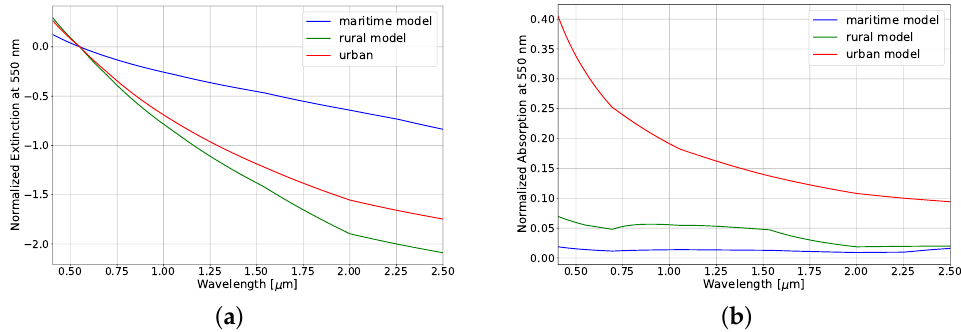
Figure 1. Normalized ( a ) extinction and ( b ) absorption coefficients of MODTRAN background aerosol